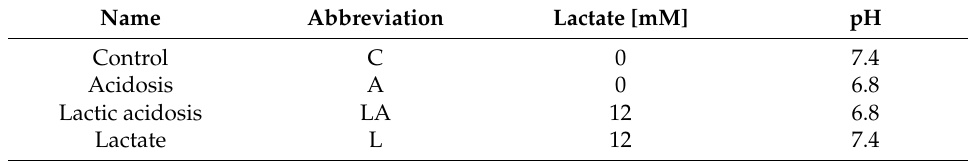
Table 1. Experimental